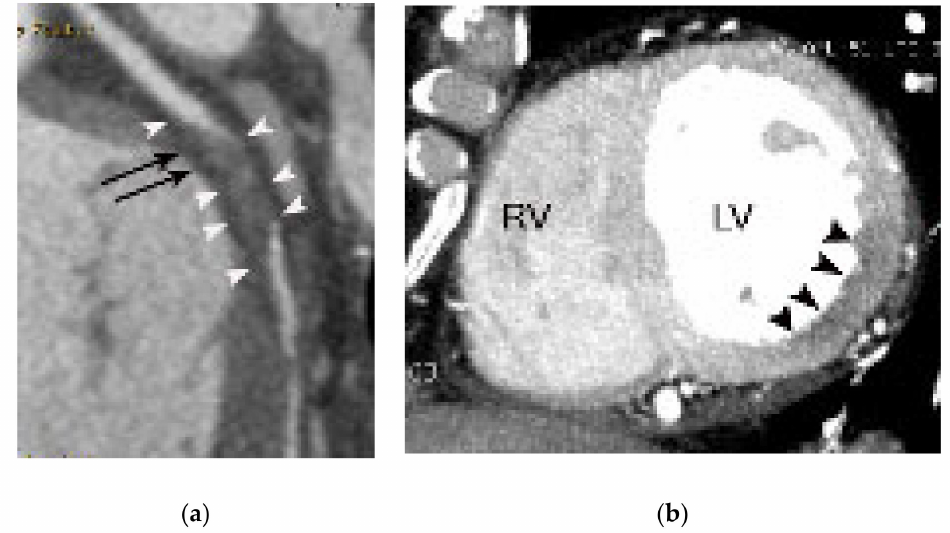
Figure 3. Fat stranding in a 75-year-old male patient with acute myocardial infarction referable to the left circumflex coronary artery. ( a ) Total occlusion (arrowheads) is noted in the proximal portion of the distal left circumflex coronary artery. Note the positive remodeling and subtle irregular lines (arrows) at the epicardial fat interface near the occluded coronary wall, suggesting epicardial fat stranding. ( b ) Subendocardial hypoattenuation (arrowheads) is demonstrated in the territory of the left ventricle on a short-axis view, consistent with myocardial necrosis. RV and LV indicate right and left ventricle,